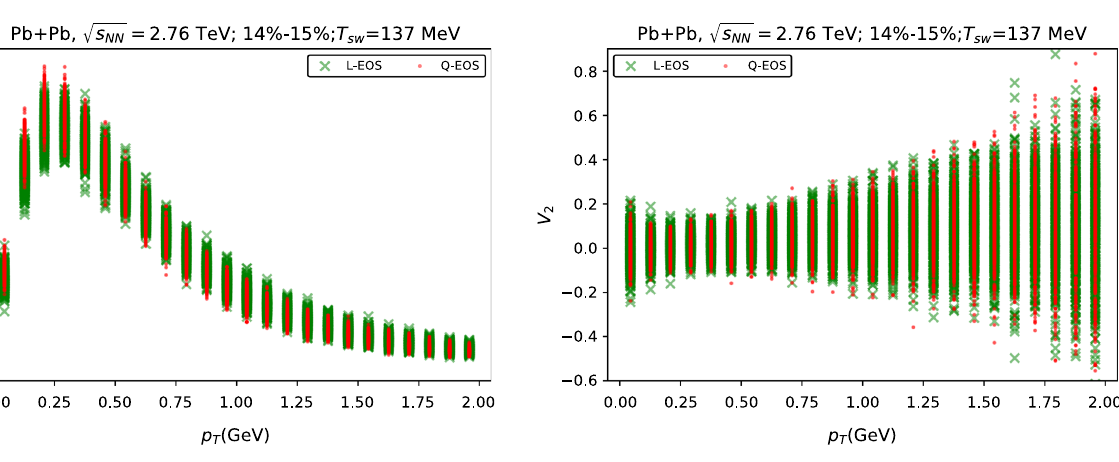
symbol depict the observables with L-EOS and Q-EOS, respectively. These events are generated in centrality bin 14%–15% with T s w = 137